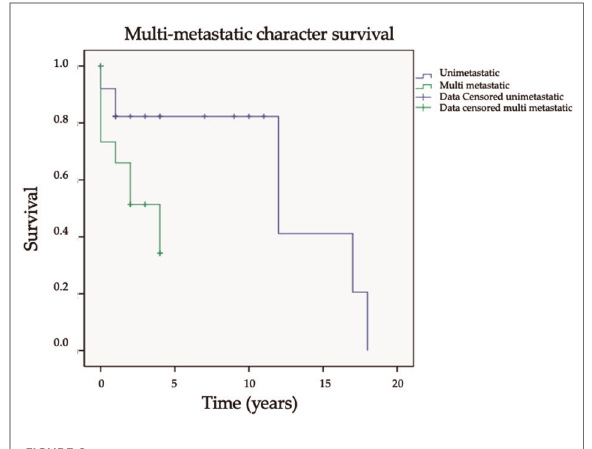
FIGURE 2 Survival curve for single bone metastasis and plurimetastatic patients ( p =0.022 Log Rank).